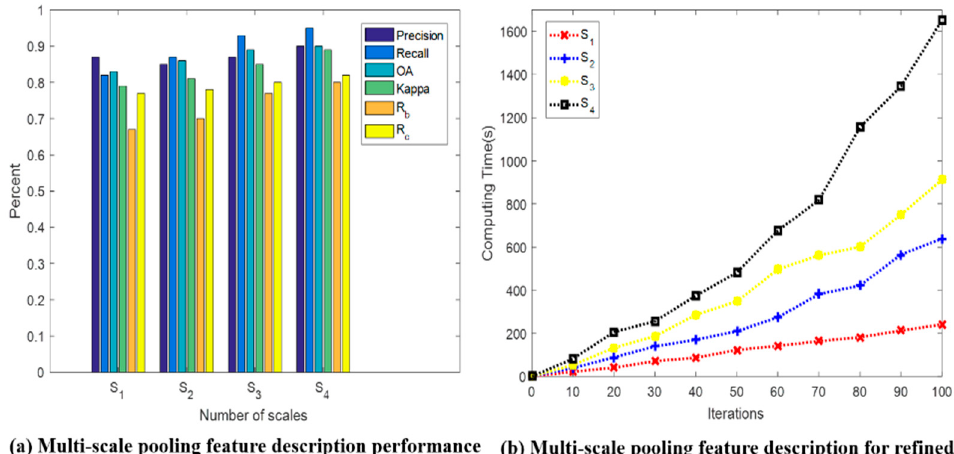
Figure 10. Multi-scale pooling feature description analysis. ( a ) shows the performances of multi-scale pooling feature description with different number of pooling scales for refined water body extraction, ( b ) shows time consuming of multi-scale pooling feature description with different pooling scales.